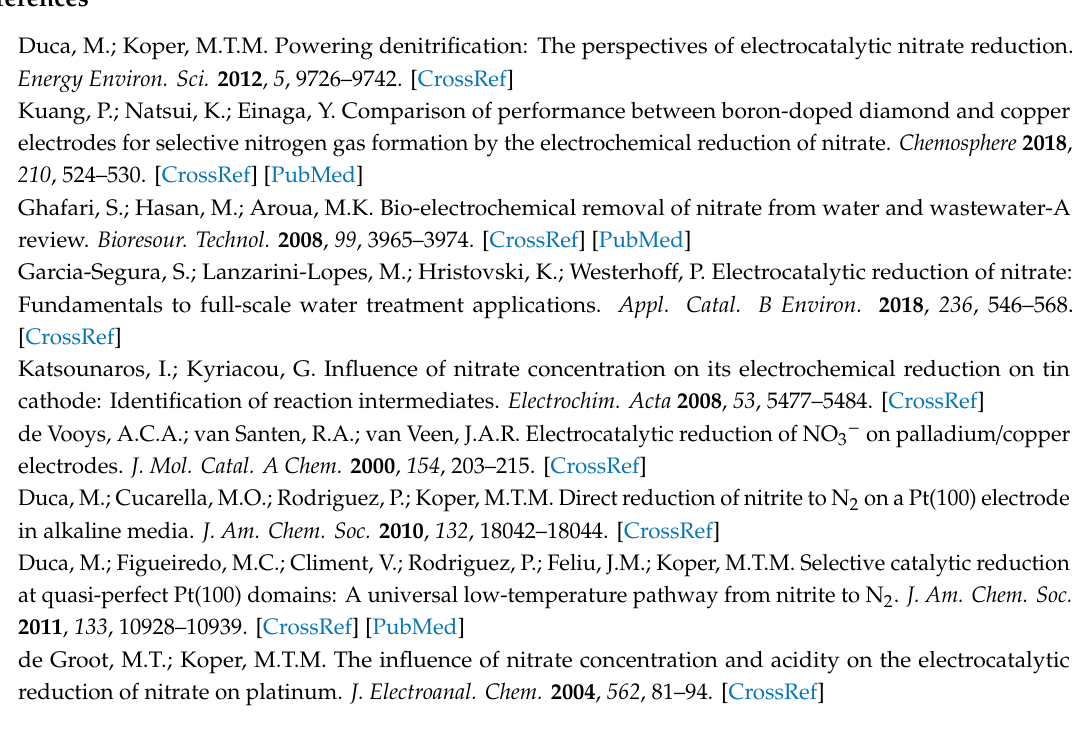
Figure S1: XPS survey spectra of Pt NFs / CC and Cu / Pt NFs / CC, Figure S2: (A)H stripping curve of Pt NFs / CC (blank curve) and Cu stripping curve of Cu depo 0.2 V / Pt NFs / CC (red curve) in 0.5 M H 2 SO 4 , (B) CVs of Cu depo 0.2 V / Pt NFs / CC in 0.1 M NaOH containing 20 mM NO 3 − . Scan rate is 20 mV s − 1